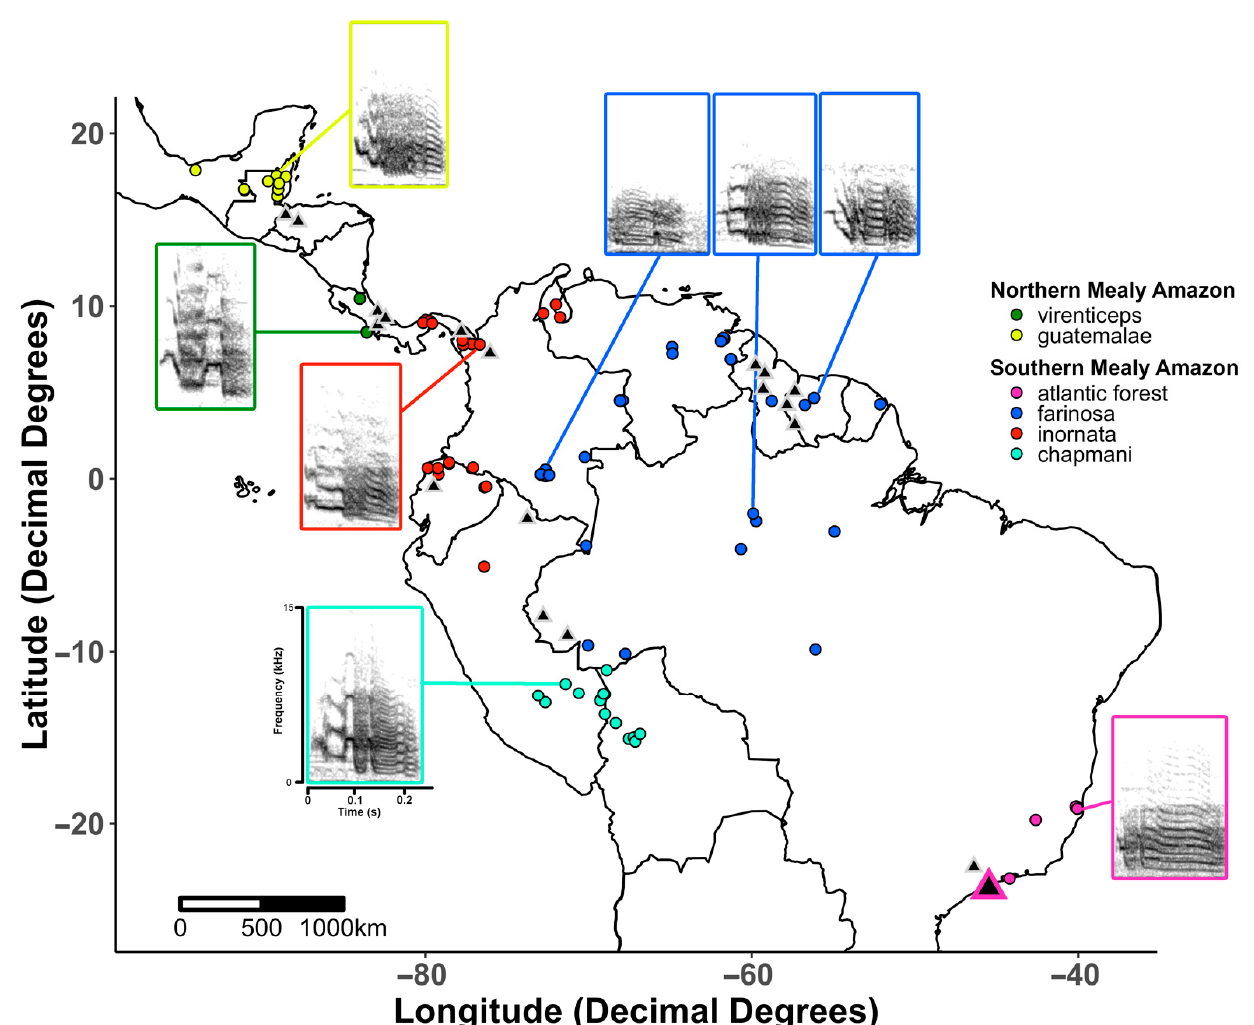
Figure 1. Map of vocal sampling locations. Spectrograms of representative calls from each clade are shown at their corresponding recording location. Spectrograms were created using the ‘spec_param’ and ‘specreator’ functions in warbler to optimize the visualization parameters (overlap = 90, window length = 475, color levels = ( − 50, 0, 5)). Genetic samples from the [36] study are indicated by grey-outlined triangles on the map. The location of the new genetic samples used in our study is indicated by the purple-outlined triangle.